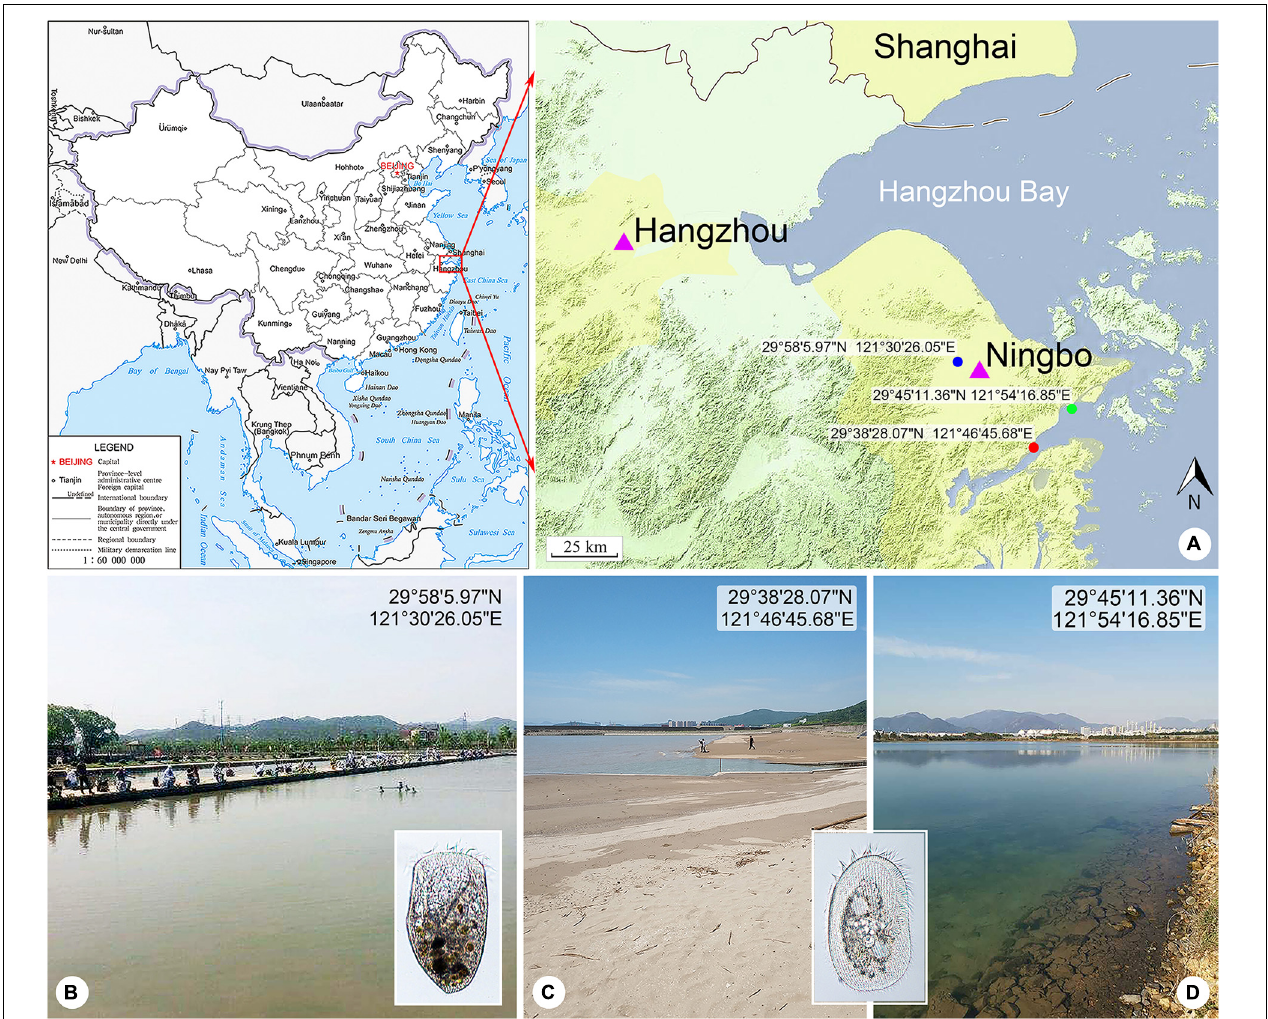
FIGURE 1 | Locations of the sample sites. (A) Maps showing the locations of the freshwater pond (blue spot), coastal brackish lake (green spot), and Xiangshan Bay (red spot). The map of China [drawing review number: GS (2019)1652] cited from the MAP WORD (www.tianditu.gov.cn). (B) Freshwater pond near Yong River where Linostomella pseudovorticella n. sp. was collected. (C) Intertidal sandy beach near Xiangshan Bay where Peritromus kahli population-II was collected. (D) Brackish lake near Meishan Island where Peritromus kahli population-I was